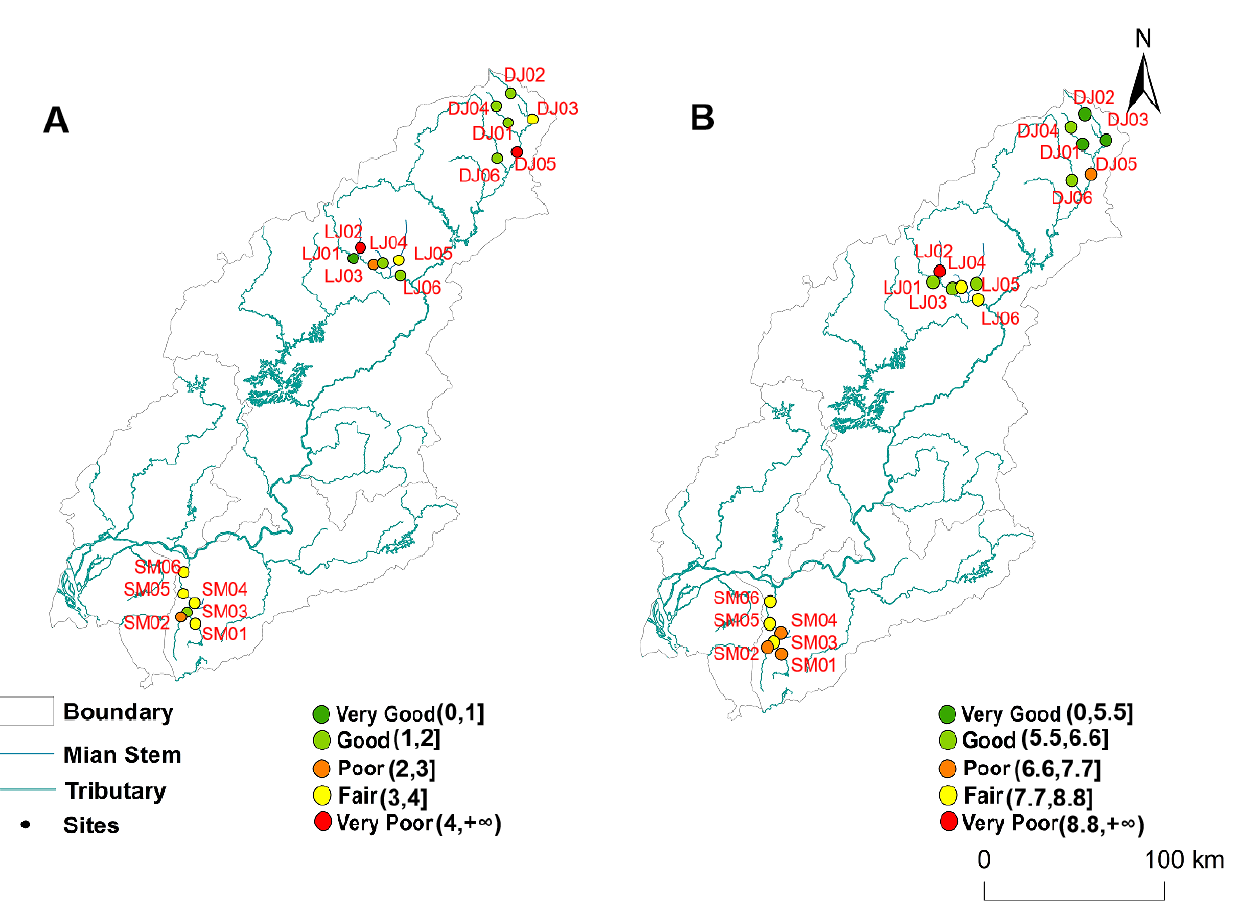
Figure 5. Classification of the ecological status, assessed by the eDNA-based Shannon–Weiner index ( A ) and the biotic indices ( B ) in Dongjiang River.